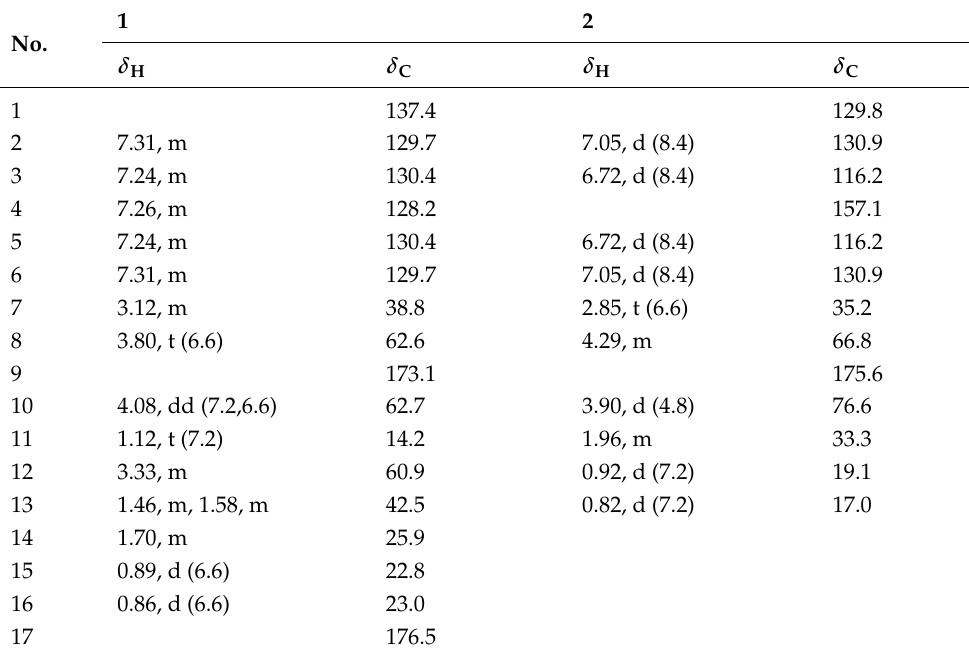
Table 1. 1H NMR (600 MHz) and 13 C NMR (150 MHz) data of compounds 1 and 2 in methanol-d 4 .